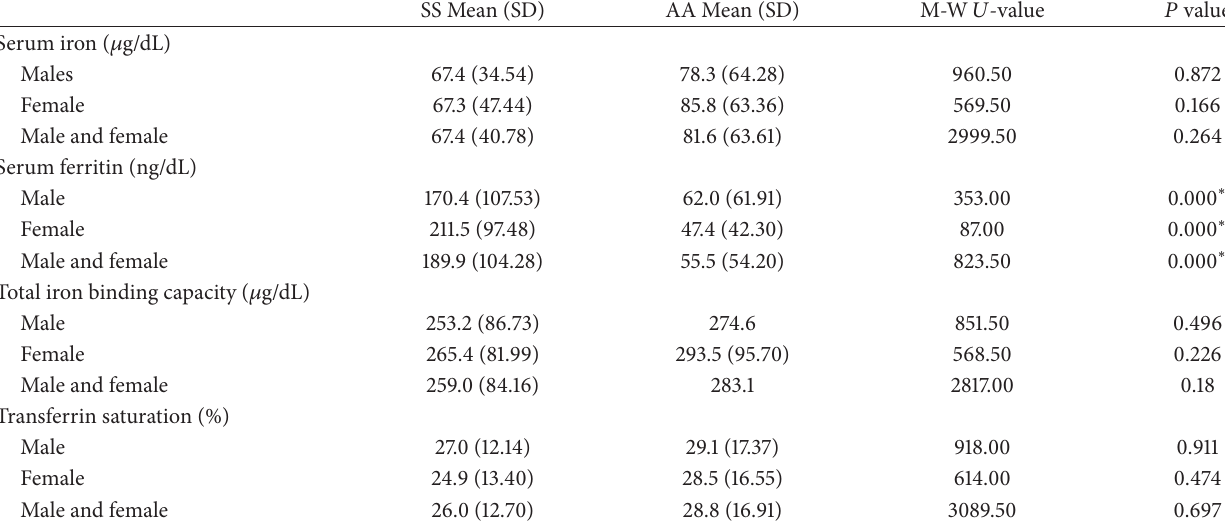
Table 2: Serum iron, serum ferritin, total iron binding capacity, and transferrin saturation profile of study